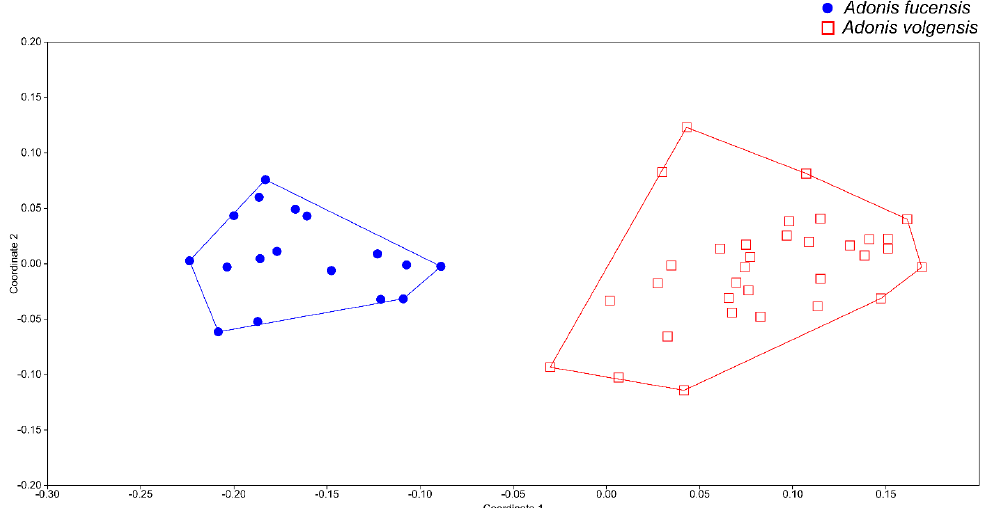
Figure 1. Non-metric multidimensional scaling scatterplot showing the first two dimensions of the analysis.